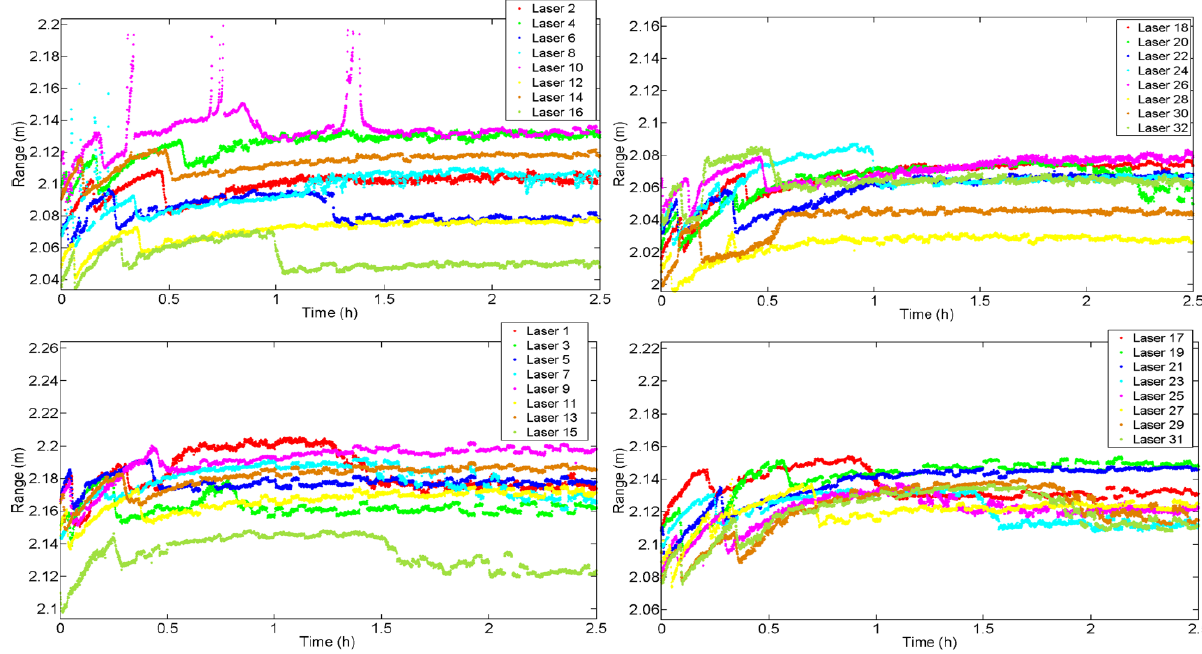
Figure 3. Range measurement for a fixed Spectralon target versus time. The range measurements are plotted in groups of eight adjacent rangefinders according to the numbering system shown in Figure